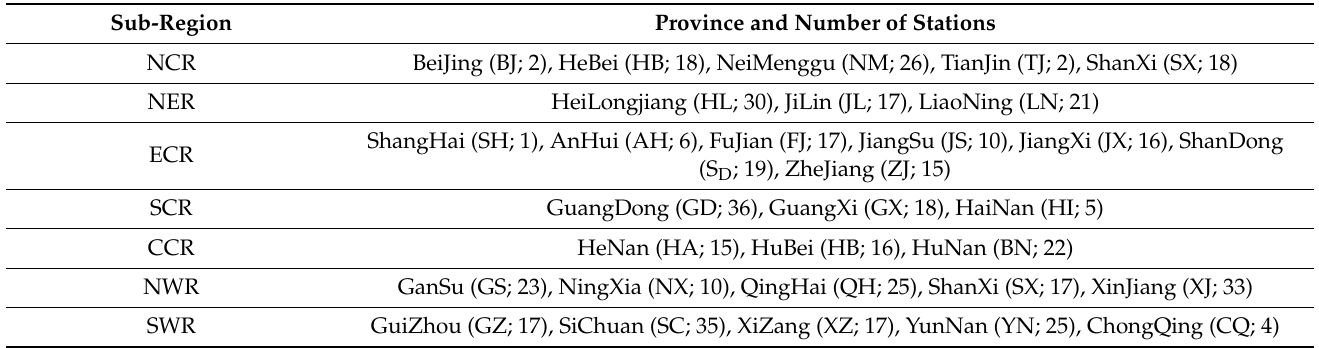
Table 1. The study area, province, and corresponding number of